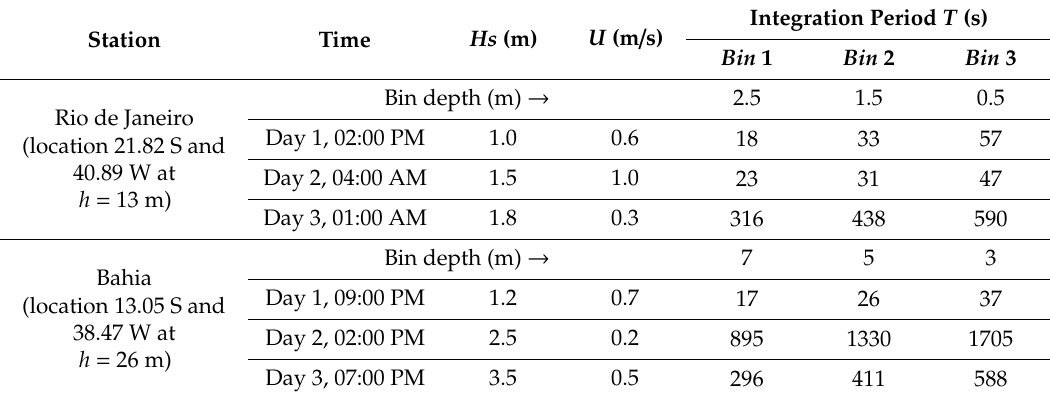
Table 1. Values of the integration period for the ensemble of currents under di ff erent sea states. The stations comprise only one ADCP Workhorse 600 kHz for current and wave